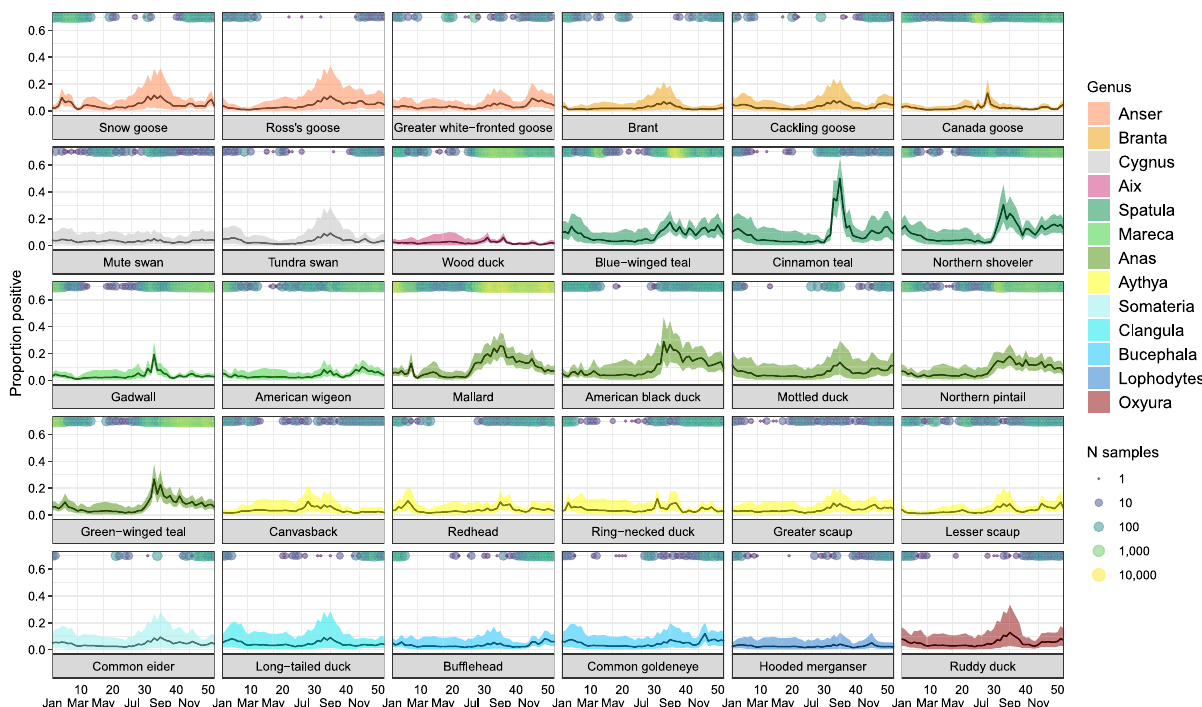
Figure 2. Percentage of individuals predicted to test positive for IAV (± 95% CI) for each species for each week. Predictions are based on the overall prevalence values in the USDA dataset, which had a higher detection rate, and ignore the spatial component. Circles running along the x-axis indicate the number of samples for each species taken during that week. Estimates for time periods without samples for a given species should be taken with caution as predictions are primarily based on the among-species correlation. Detailed images for each species can be found in Supplementary Material 3.